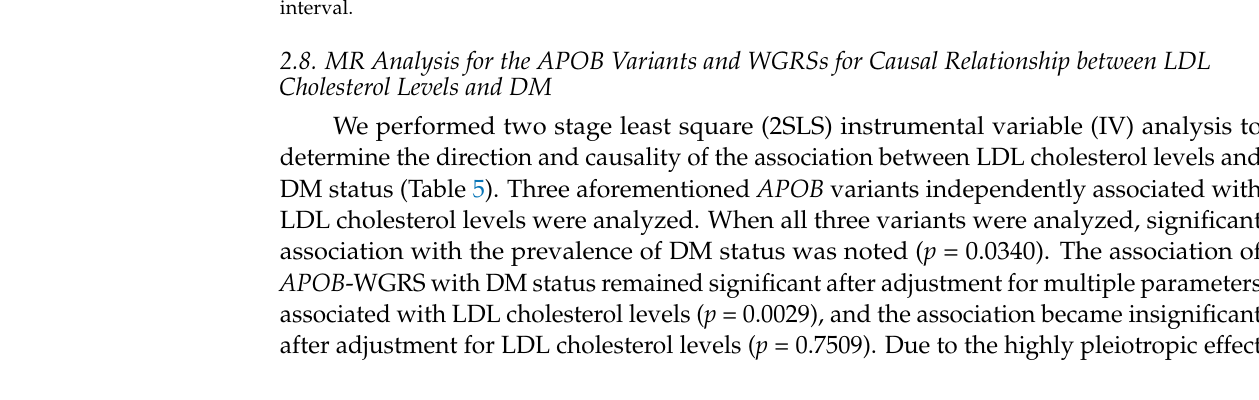
Participant recruitment criteria for analysis are displayed in Figure 1. Abbreviation as in Table 2.